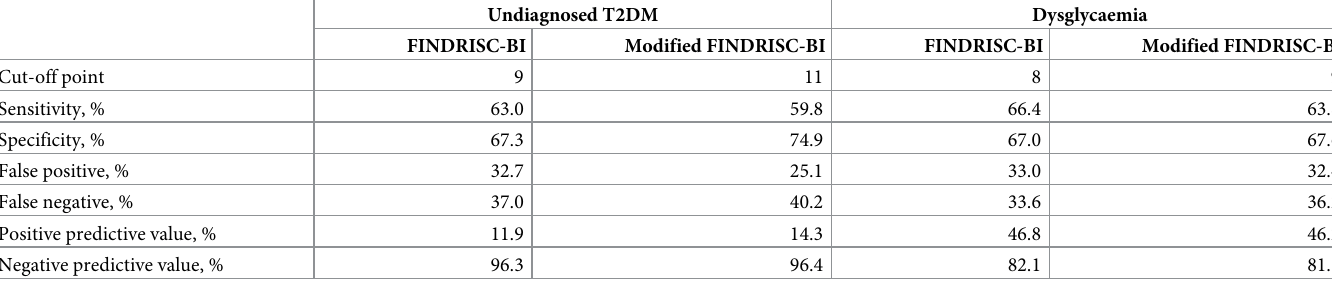
Table 2. Characteristics of FINDRISC-BI and Modified FINDRISC-BI using the optimal cut-off scores to detect undiagnosed T2DM and